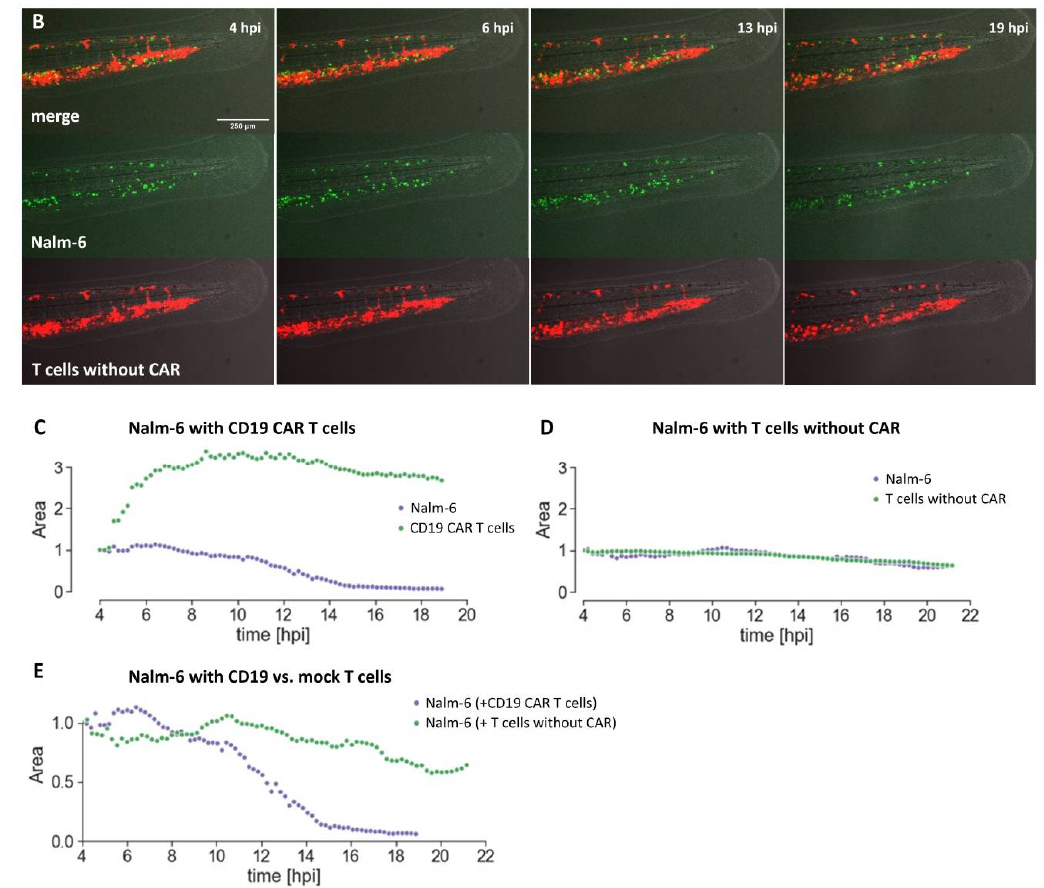
Figure 4. Quantifying specific elimination of Nalm-6 cells over time. Zebrafish embryos were injected with Nalm-6 cells (green) at approximately 48 hpf. Around 2 hours later, either CD19 CAR T cells (red cells in ( A )) or T cells without a CAR (red cells in ( B )) were injected and a time-lapse movie was recorded, starting approximately 4 hours post injection of T cells. Several time points of one embryo co-injected with CD19 CAR T cells ( A ) or mock T cells ( B ) are shown as single frames. ( C ) Quantification of cells over time based on the fluorescent area using Fiji. Nalm-6 (blue dots) in the presence of CD19 CAR T cells (shown as green dots), or the presence of T cells without CAR ( D ). ( E ) Nalm-6 in the presence of CD19 CAR T cells (blue) and T cells without CAR (green) over time. Images were recorded on a Leica SP8 X WLL confocal microscope and rendered with Adobe Photoshop CS6. Scale bar in ( A ) represents 250 µm.